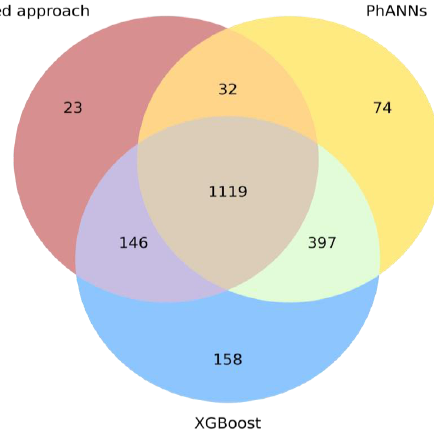
Figure 5. Venn diagram of the concordance between correct positive predictions made by the three benchmarked methods: our domain-based approach, our XGBoost classifier, and